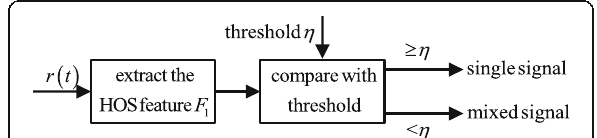
Fig. 2 The block diagram of the proposed identification